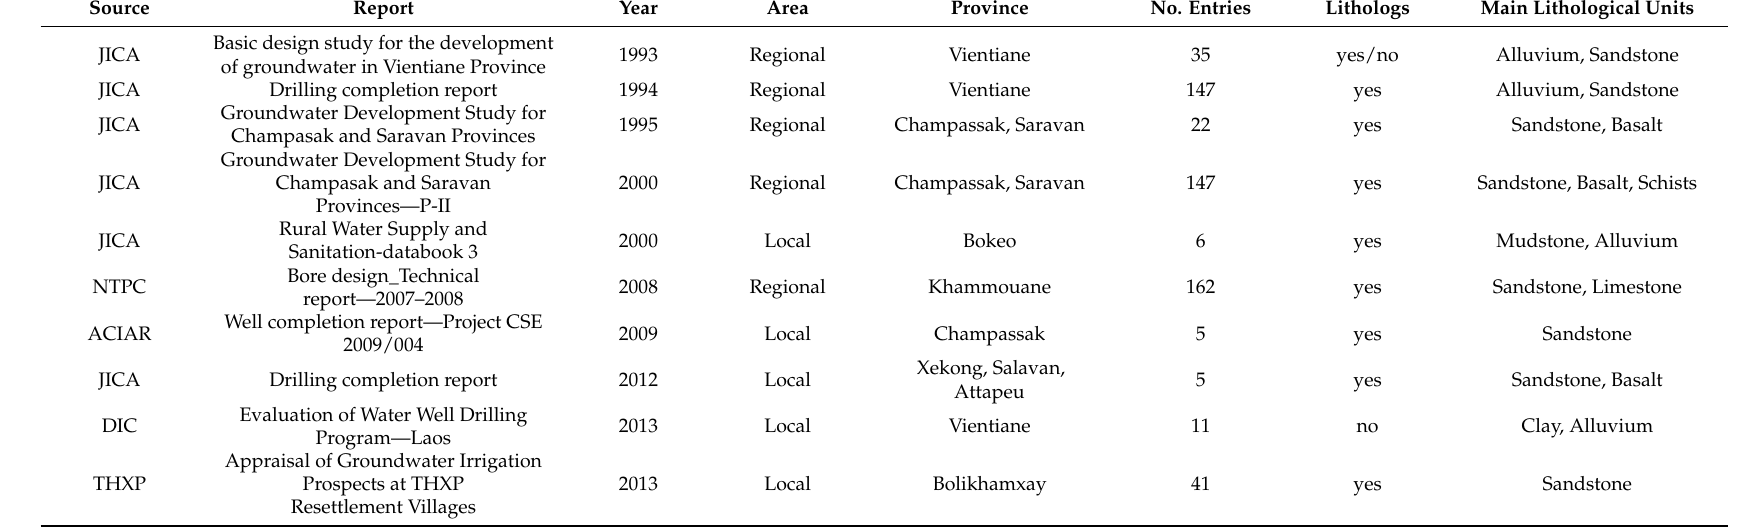
Table 2. Data sources used in building borehole database. Sources: JICA: Japanese International Cooperation Agency [14–19]; NTPC: Nam Theun Power Company [22]; ACIAR: Australian Centre for International Agricultural Research [20]; DIC: Deseret International Charities [21]; THXP: Theun Hinboun Expansion Project